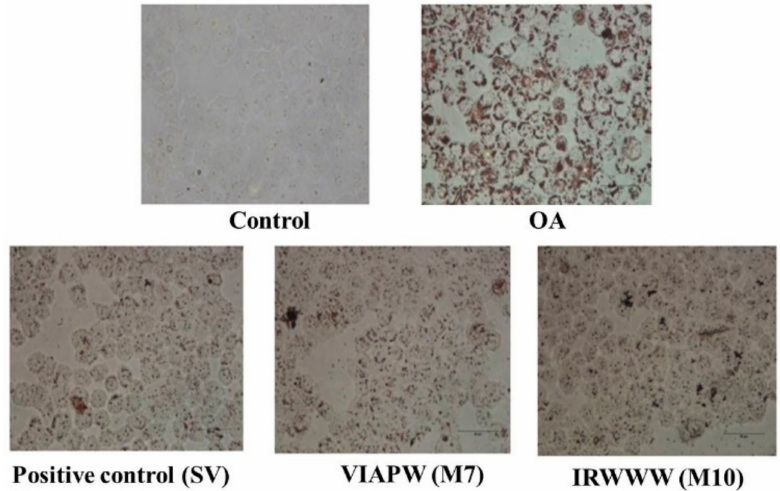
Figure 3. E ff ects of VIAPW (M7) an, IRWWW (M10) from miiuy croaker ( M. miiuy ) muscle at the concentration of 100 µ m on morphological characteristics of HepG2 cells for 24 h compared to normal and positive control (simvastatin (SV)) groups. The images were taken using an inverted microscope ( ×